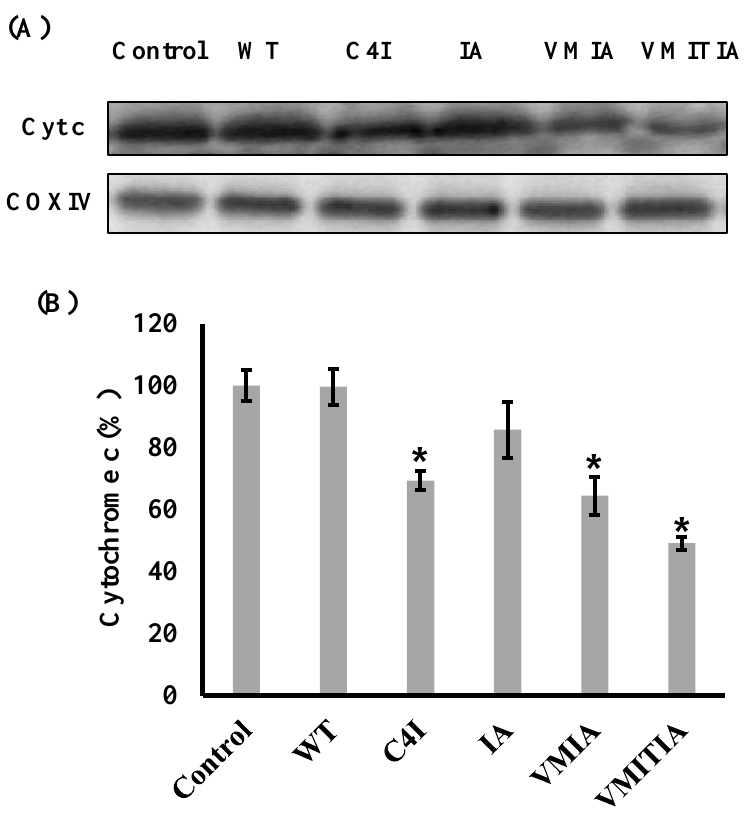
Figure 3. Effects of DENV3-ED3 variants on mitochondrial outer membrane integrity. Outer mem- brane integrity was evaluated by measuring cytochrome c release using Western blotting. Mito- chondria from porcine hearts were incubated with the DENV3-ED3 variants. Control mitochondria were treated with Tris-sucrose buffer alone. ( A ) Western blot analysis of cytochrome c (Cyt.c) and cytochrome oxidase subunit IV (COXIV) inside mitochondria after incubation; ( B ) statistical analysis of the amount of cytochrome c inside mitochondria after incubation. The percentage of cytochrome c was expressed as a ratio of the band intensities for cytochrome c and COXIV. The average control values were normalized to 100%. Data represent the mean ± SEM ( n = 3). * p < 0.05 vs.